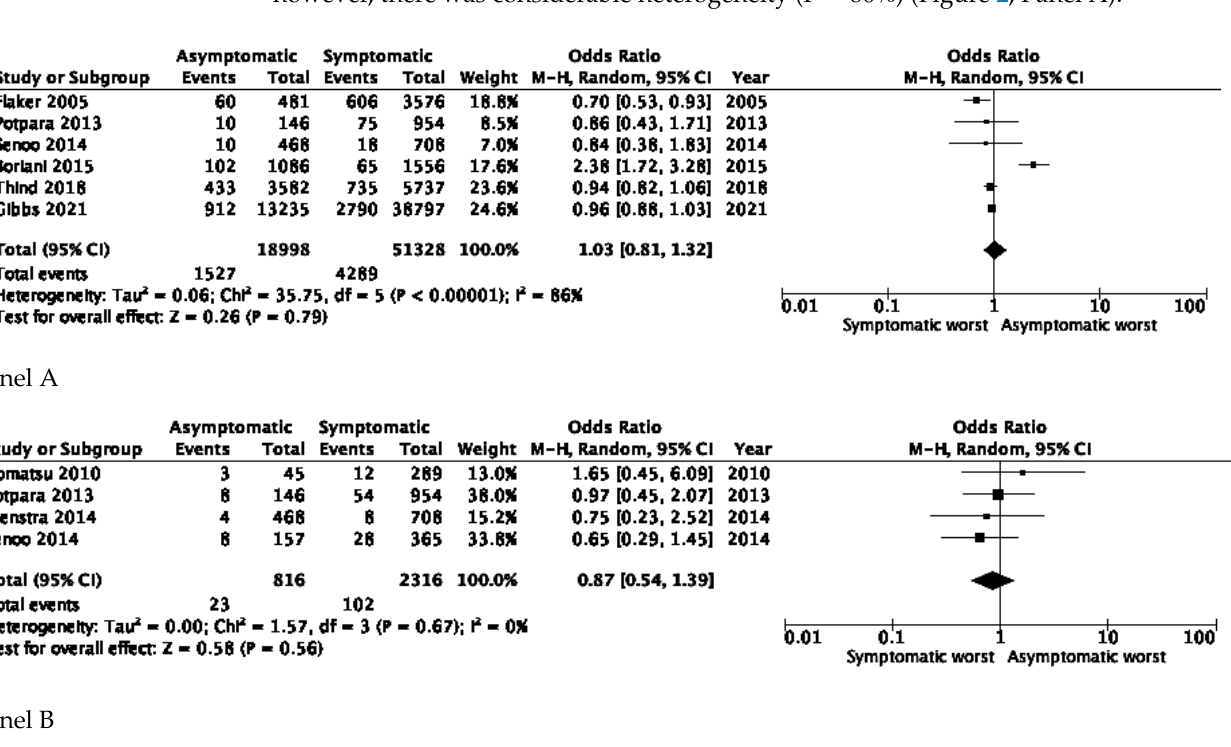
Figure 2. All cause and cardiovascular mortality. Panel ( A ) All-cause death in asymptomatic and symptomatic AF patients. Panel ( B ) Cardiovascular death in asymptomatic and symptomatic AF patients.